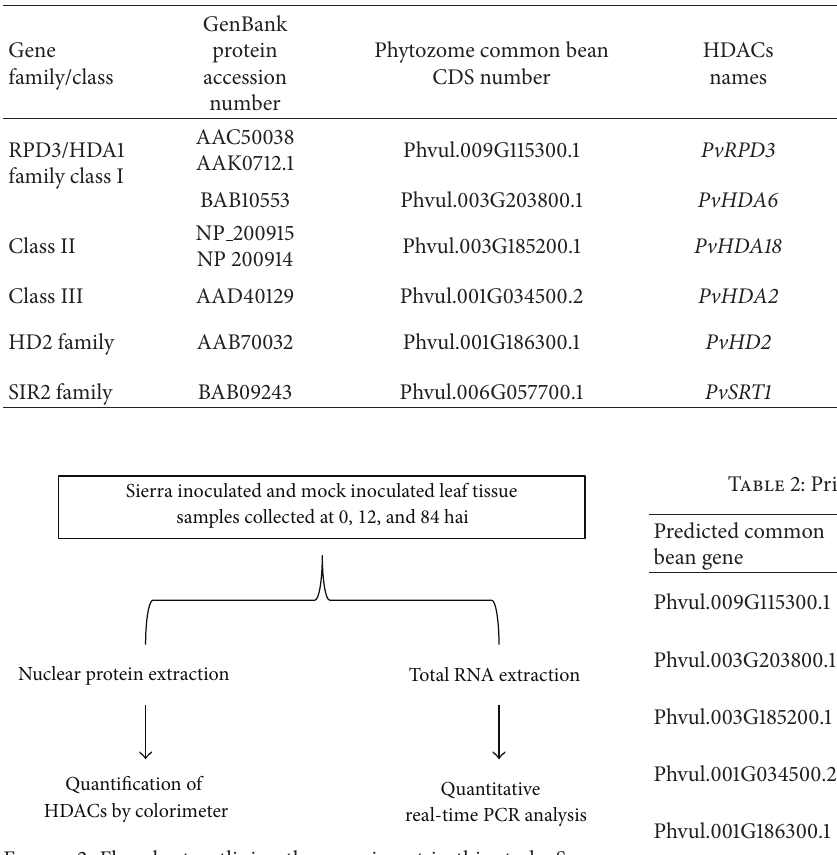
Table 1: Selected representative HDAC genes for expression analysis. GenBank protein accession number and corresponding predicted common bean homologs along with location on the common bean genome.